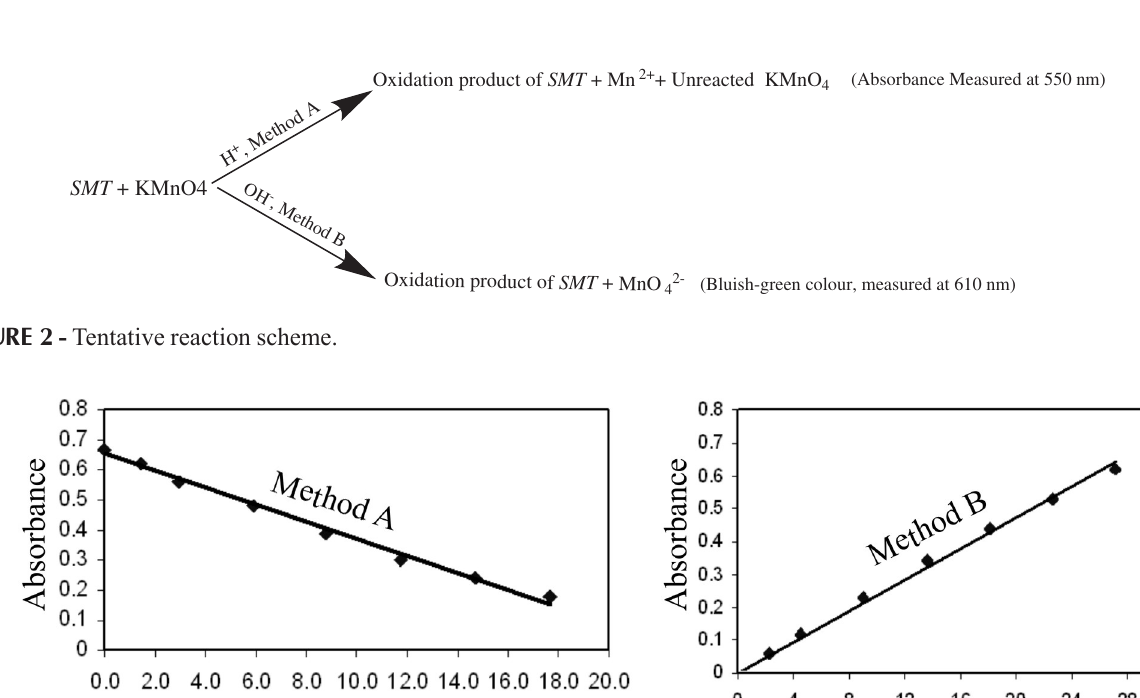
FIGURE 3 - Calibration curves for method A and method